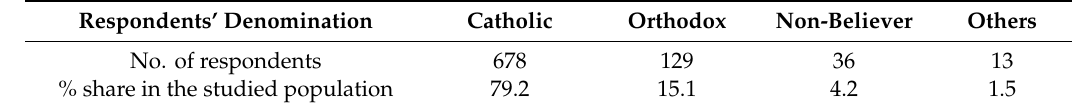
Table 2. Religious structure of the studied population.